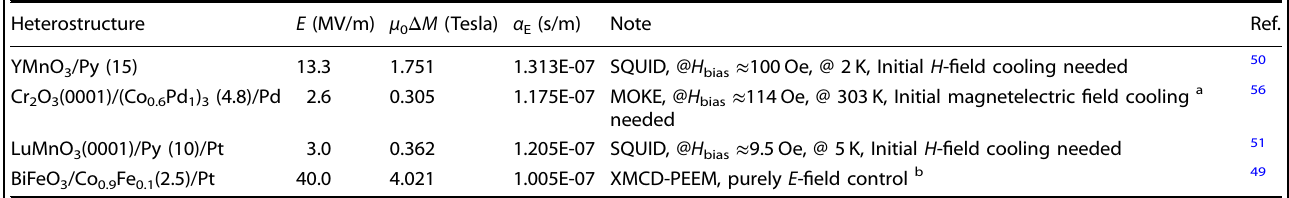
Table 3d. Converse magnetoelectric coupling mediated by electrically controlled exchange coupling across the interface Heterostructure Ref.